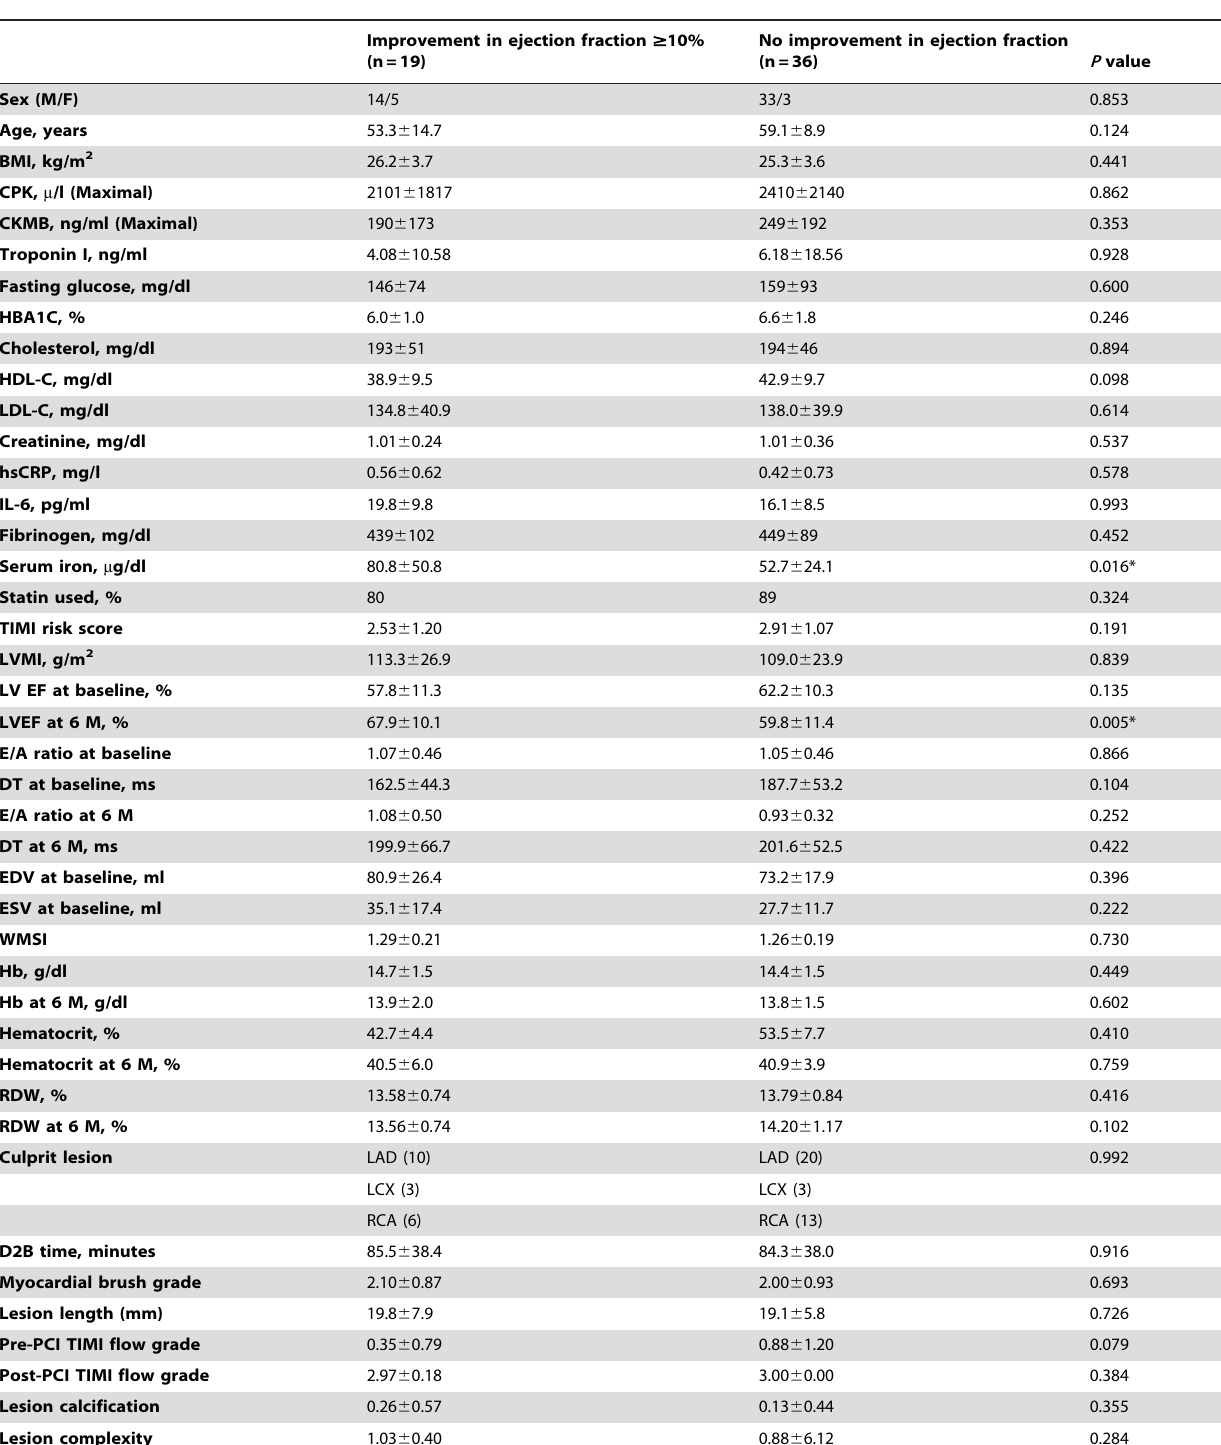
Table 1. Characteristics of patients grouped by change in left ventricular ejection fraction 6 months after percutaneous coronary interventions for acute myocardial